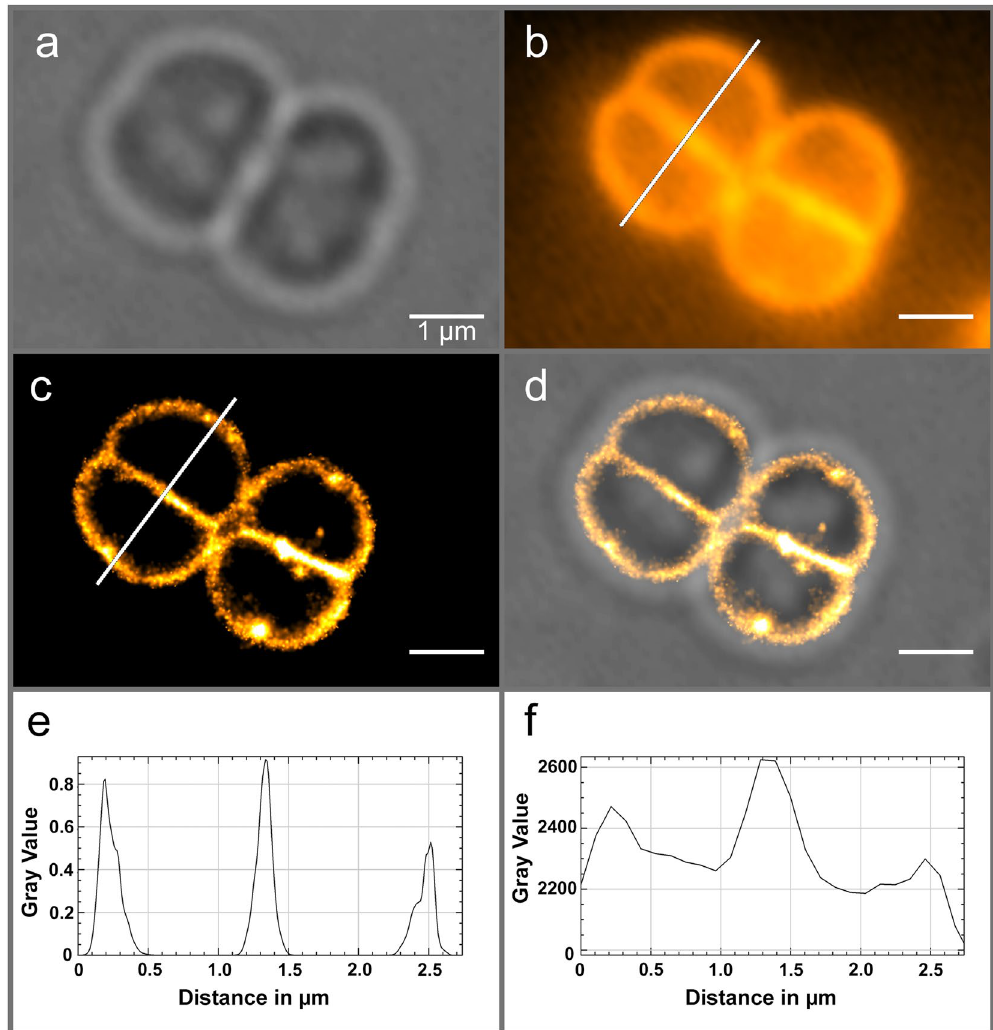
Figure 2. Autoblinking nanoscopy of live, unlabeled D. radiodurans bacterial cell walls. ( a ) Brightfield image. ( b ) Z-projection of 1000 frames of the original stack. ( c ) Super-resolved image rendered from a stack of 50,000 frames acquired under continuous 0.8 kW/cm 2 561 nm laser (Supplementary Movie S1 provides an example of 500 frames of this stack). ( d ) Superimposed image of ( a , c ). ( e , f ) Profiles along the white line of ( c , b ) respectively. Scale bar: 1 μ